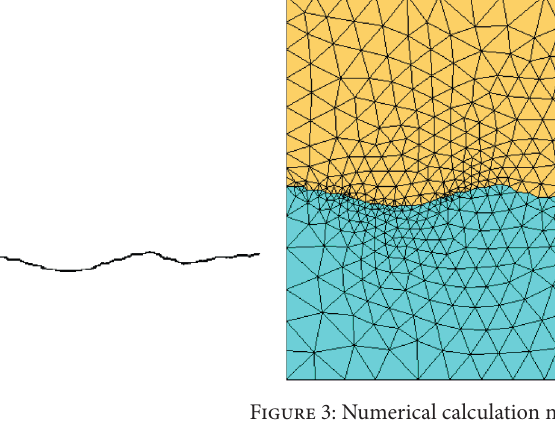
Figure 3: Numerical calculation model with JRC = 16 .